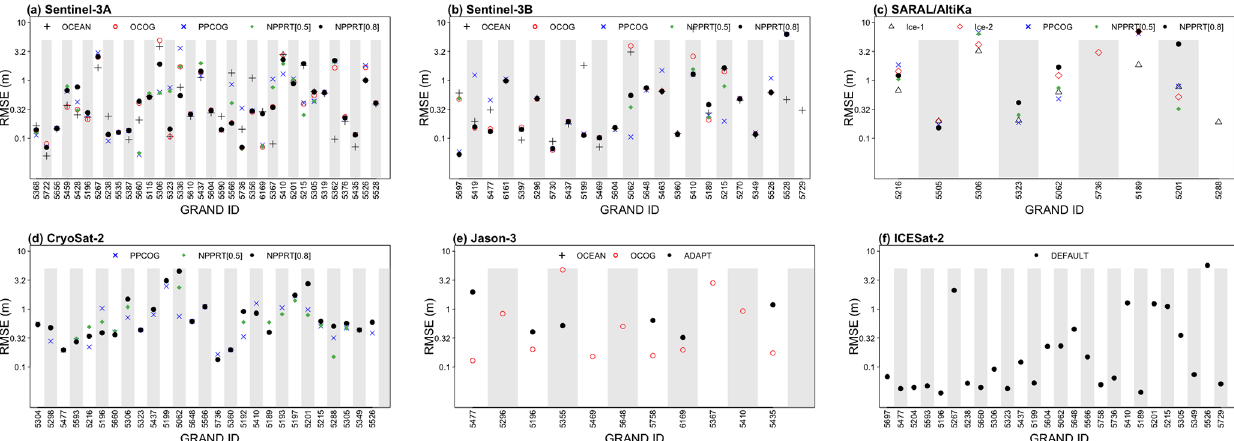
Figure 2. Comparison of the different retracking algorithms (three for CryoSat-2 and Jason-3 and one for ICESat-2) of six altimeters at validated reservoirs. Logarithmic scales are used for the y axis. The x axis refers to the reservoir GRanD IDs. For some reservoirs, occasionally, there are no useable data delivered by one specific retracking algorithm, and therefore no RMSE is available.